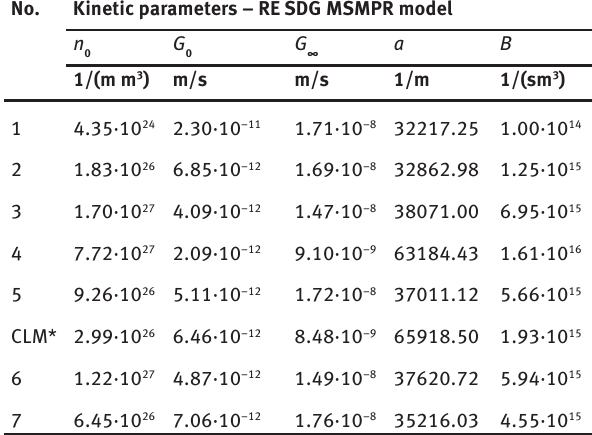
Table 4: Kinetic parameters calculated with RE SDG MSMPR model (Eqs. (7) and (8)): nuclei population density n , nucleation rate B , 0 minimal G and maximal G crystal linear growth rate, as well as 0 ∞ RE SDG MSMPR model parameter a – estimated for continuous struvite reaction crystallization process in DT MSMPR crystallizer. Corresponding process conditions – see Table